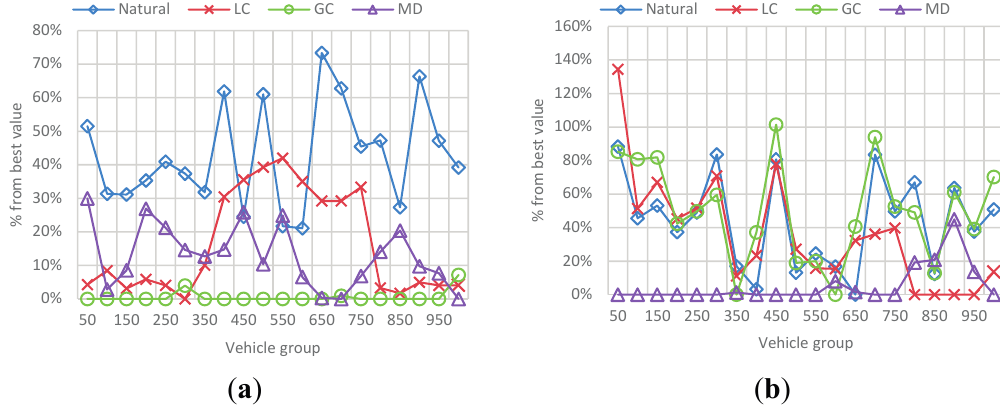
Figure 29. Behavior for route efficiency and trip distance. ( a ) Mean efficiency value for each 50-vehicles in a 100 vehicles sample; ( b ) Mean trip distance value for each 50-vehicles in a 100 vehicles sample.